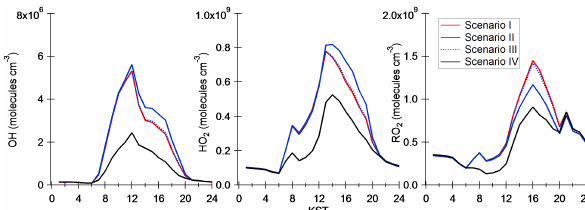
Figure 3. The temporal variations of OH (left panel), HO 2 (middle panel), and RO 2 (right panel) calculated by four different observa- tionally constrained UWCM box-model